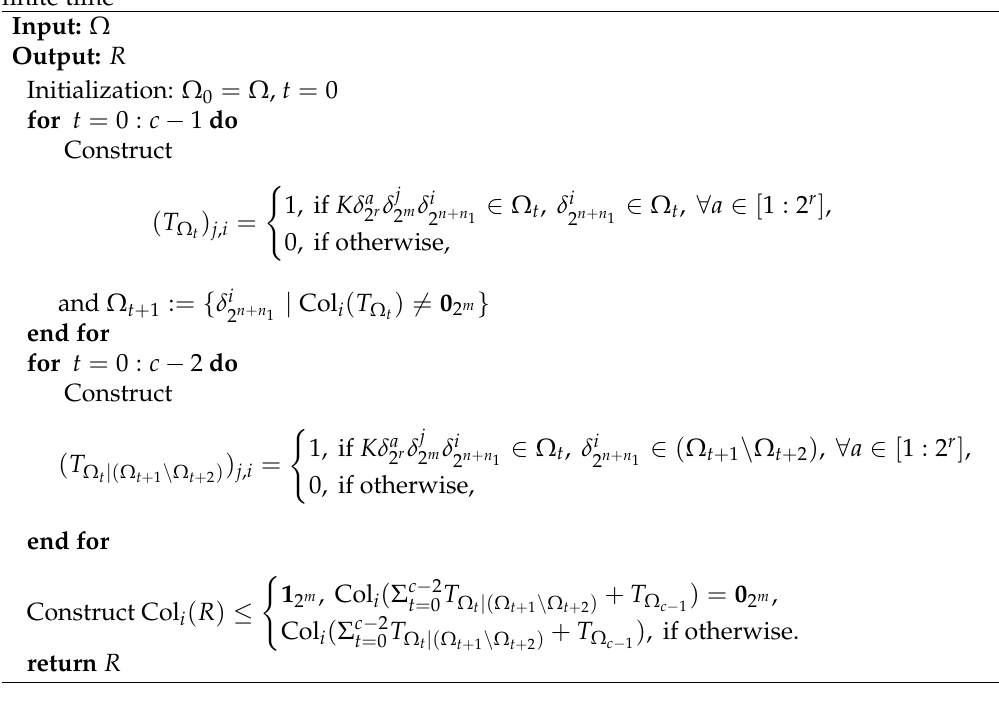
Algorithm 2 Design of controller for tracking the outputs of a reference system over finite